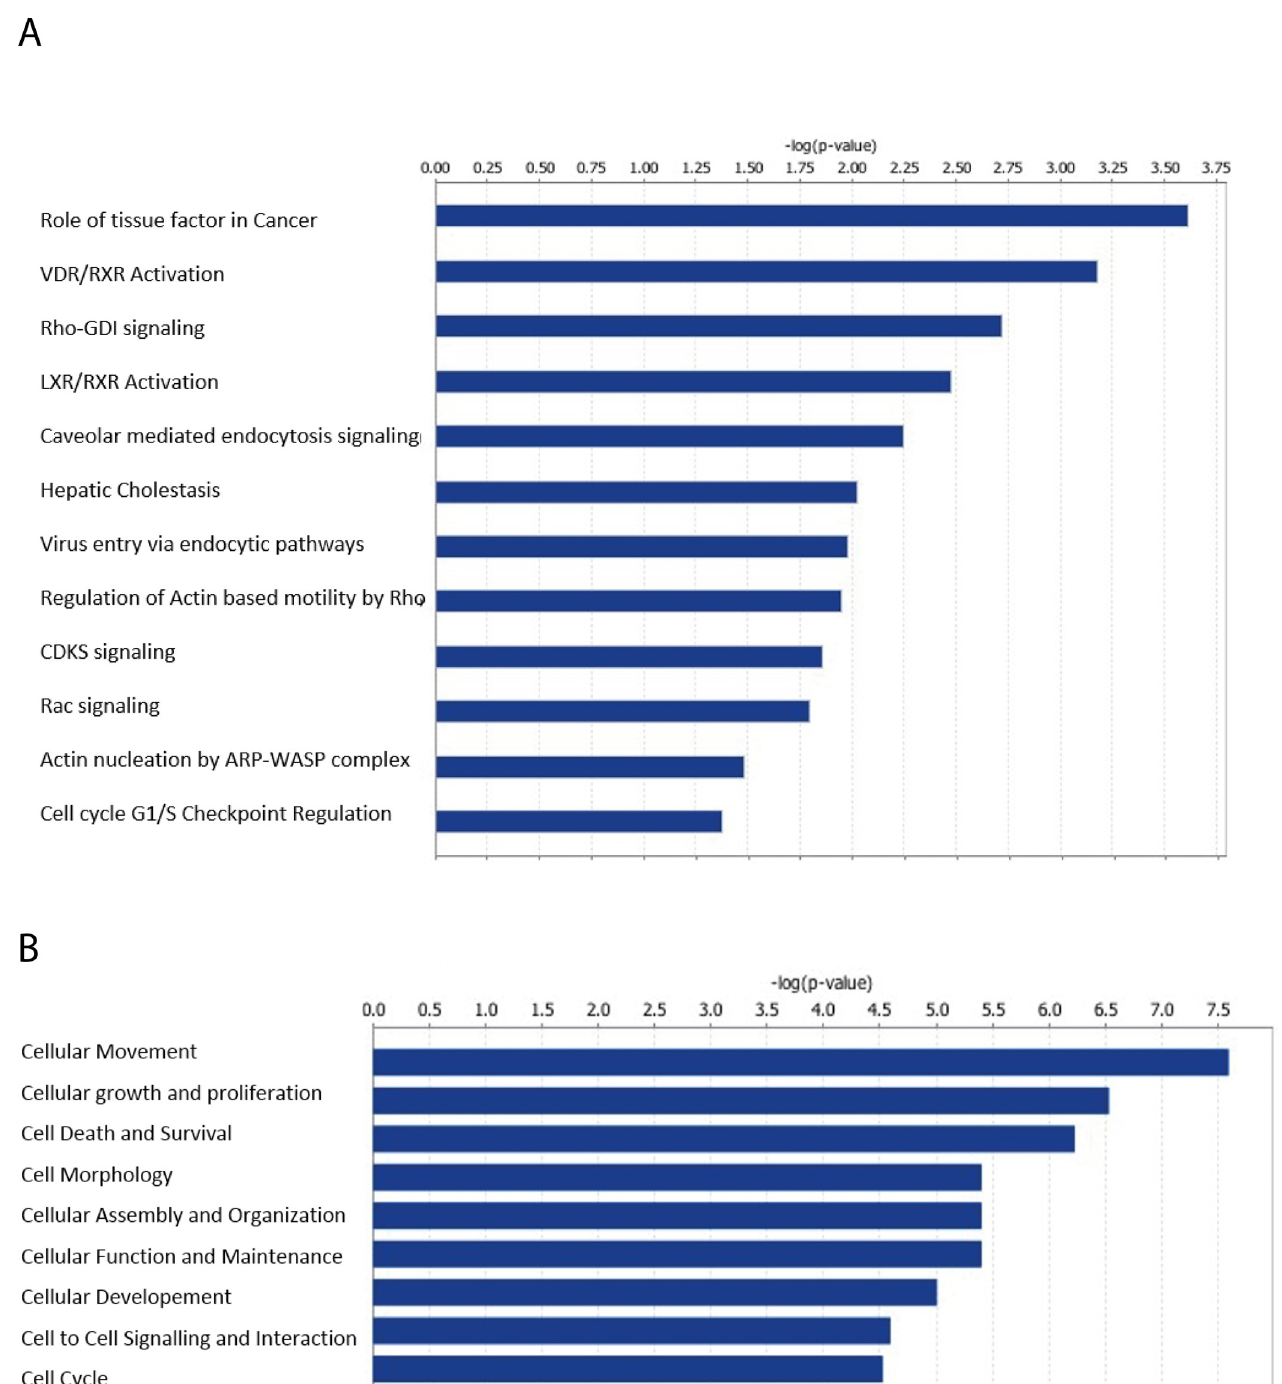
Fig 5. ATP9A knock-down in HepG2 cells affects endocytic pathways. RNA was isolated from sh-control and ATP9A knock-down HepG2 cells at 72 hours after transduction and used for microarray analysis. (A) Ingenuity pathway analysis of significantly up-regulated and down-regulated genes enriched for multiple pathways related to endocytosis. (B) Gene Ontology (GO) molecular function analysis of significantly altered genes enriched for the indicated pathways affecting cell migration, cell growth and proliferation, and cell death and survival. Pathways are arranged in order of their significance [-log(p-value)].